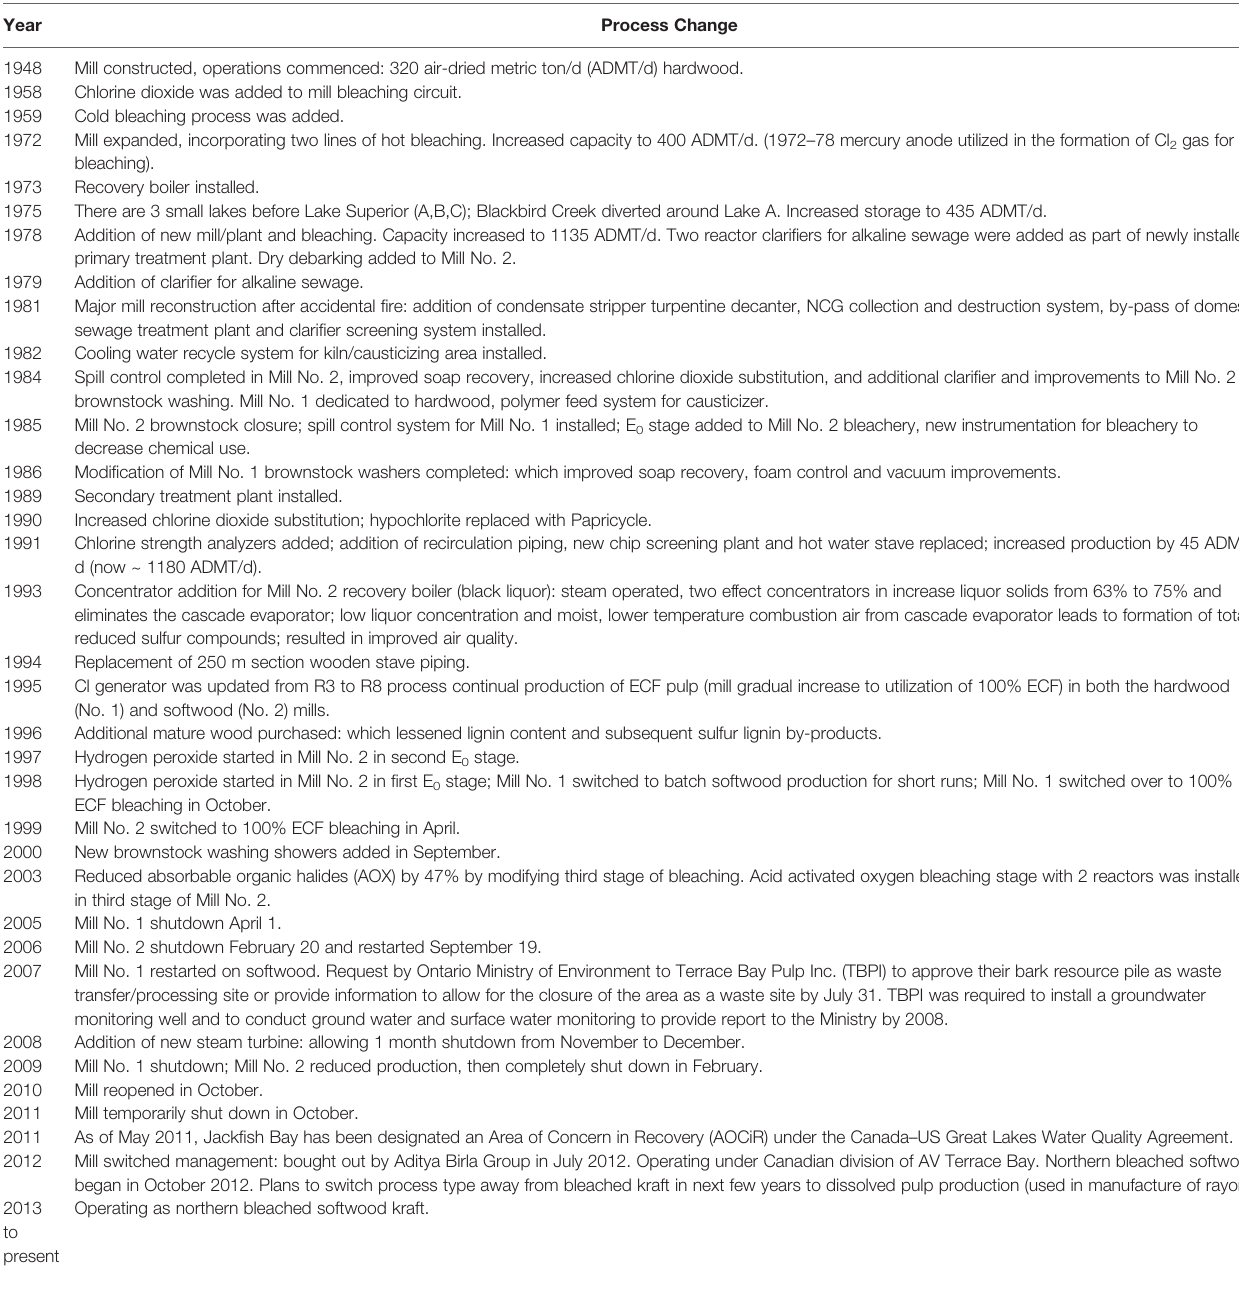
TABLE 2 | Summary of major process changes with ef fl uent quality at Jack fi sh Bay. Information in table adapted from Bowron et al.